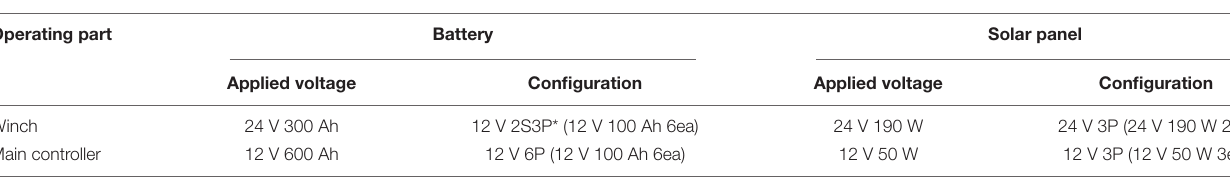
TABLE 1 | Power supply configuration of